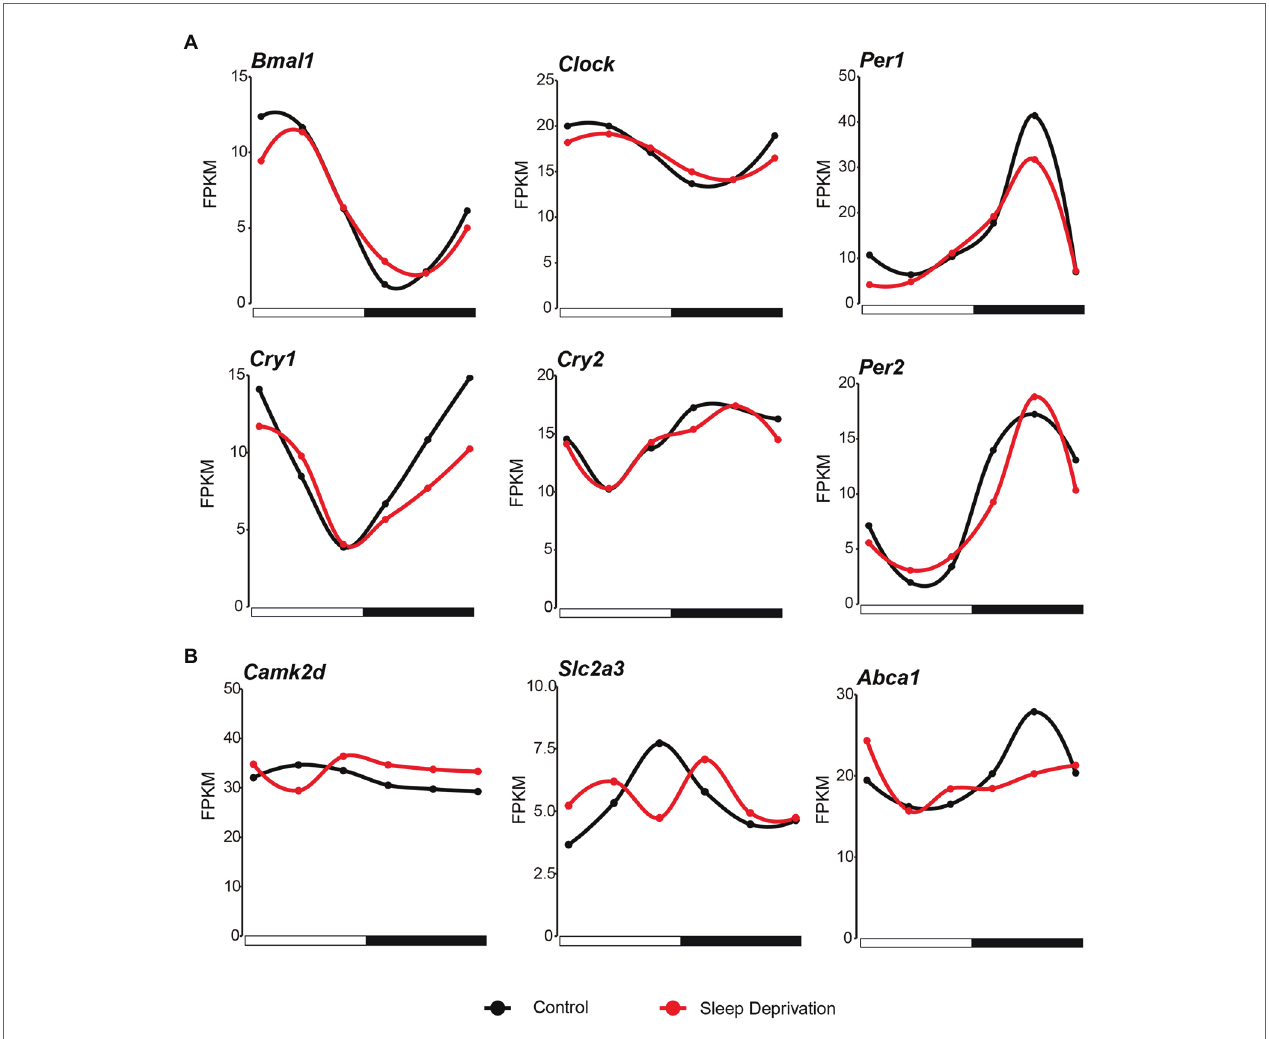
FIGURE 3 | Core circadian regulators maintain rhythmicity after sleep deprivation. (A) The circadian expression of core clock genes in the mouse lung during the 24 h in both control (black lines; time points every 4 h starting at CT4) and SD (red lines; time points every 4 h starting at CT4) conditions. (B) The mRNA expression of genes that changed the circadian behavior compared with human after sleep deprivation (black lines; time points every 4 h starting at CT4) and SD (red lines; time points every 4 h starting at CT4)